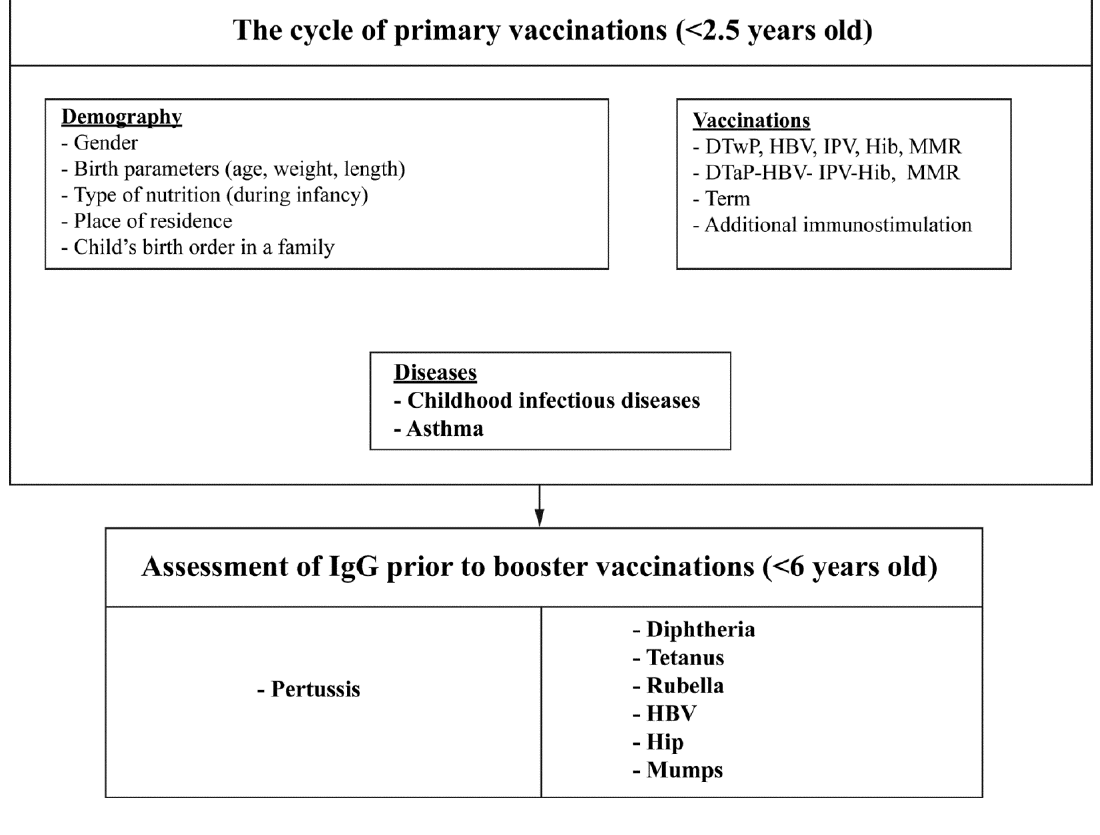
Figure 1. Research algorithm—parameters analysed included in the schedule of mandatory Figure 1. vaccinations. mandatory